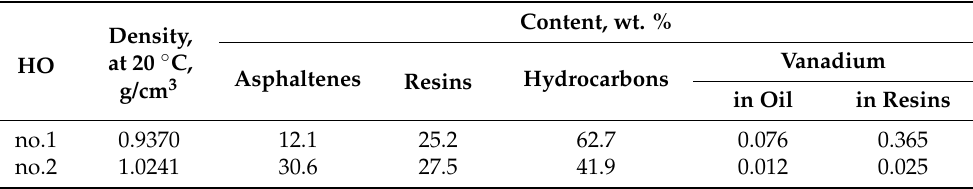
Table 1. Characteristics of heavy oils (HOs) and the resins isolated from them.